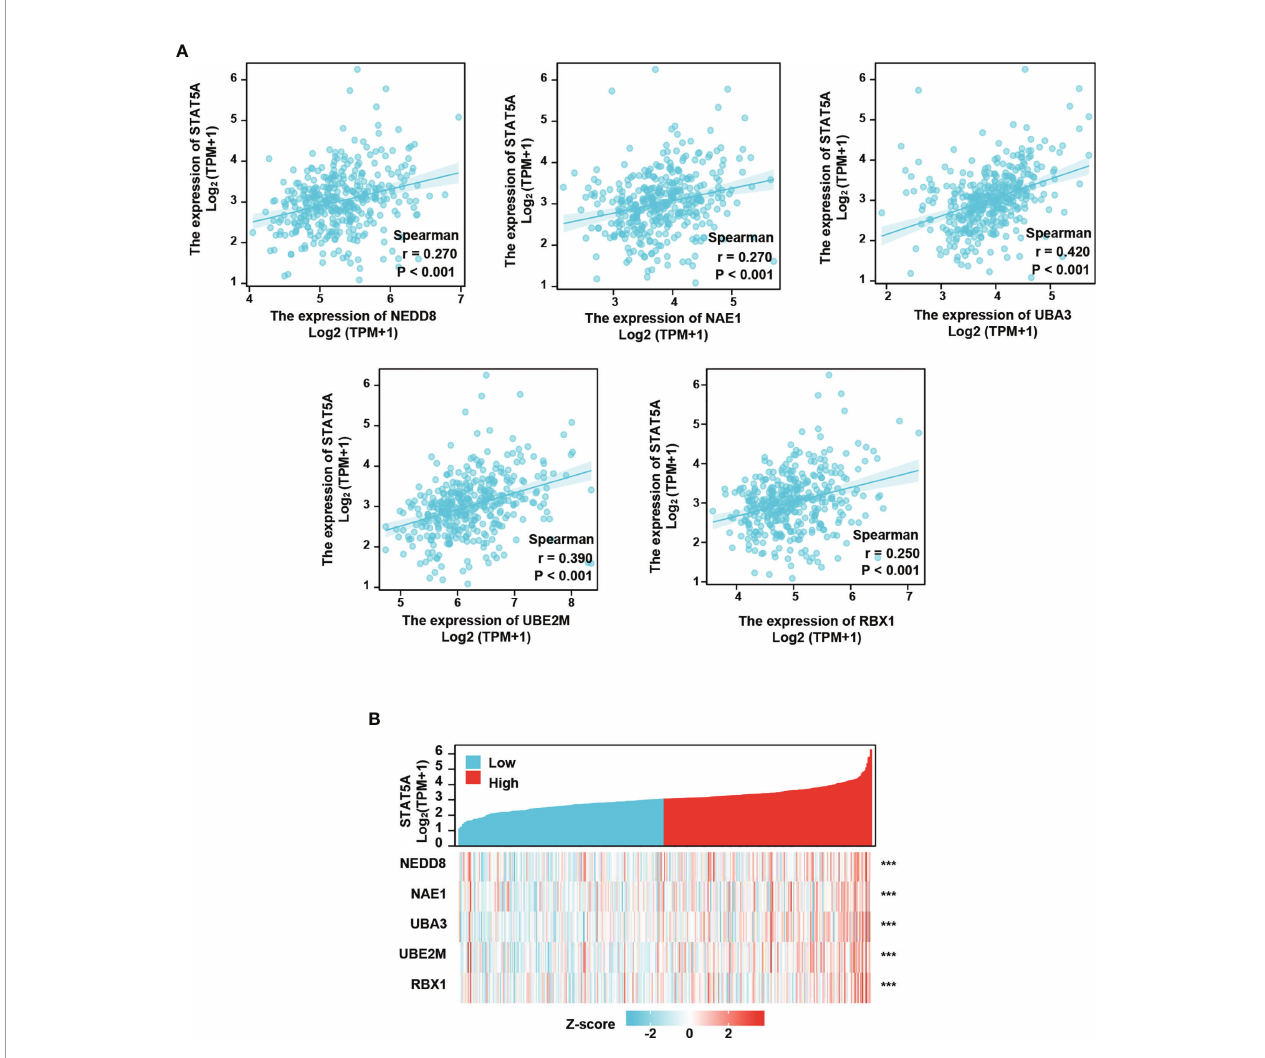
FIGURE 6 | Neddylation pathway positively correlates with STAT5A. (A) Neddylation pathway components positively correlate with STAT5A. (B) Neddylation pathway components are increased in STAT5A high group. ***P<0.001, for the indicated